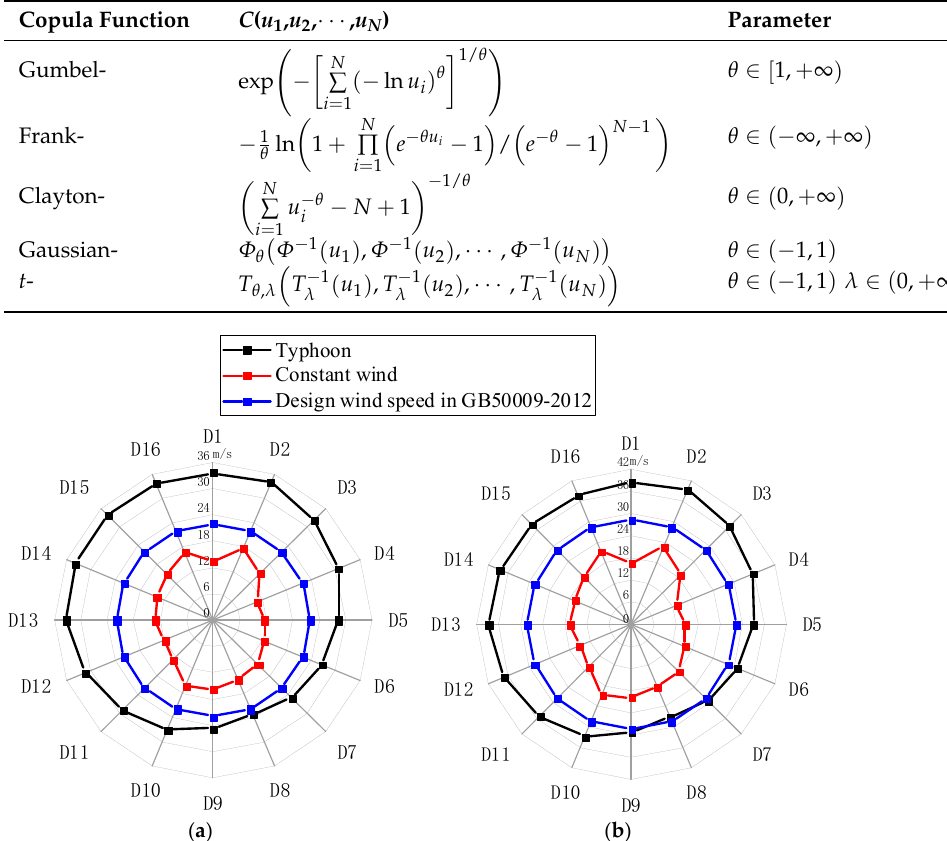
Table 1. Commonly used multi-dimensional Copula functions.